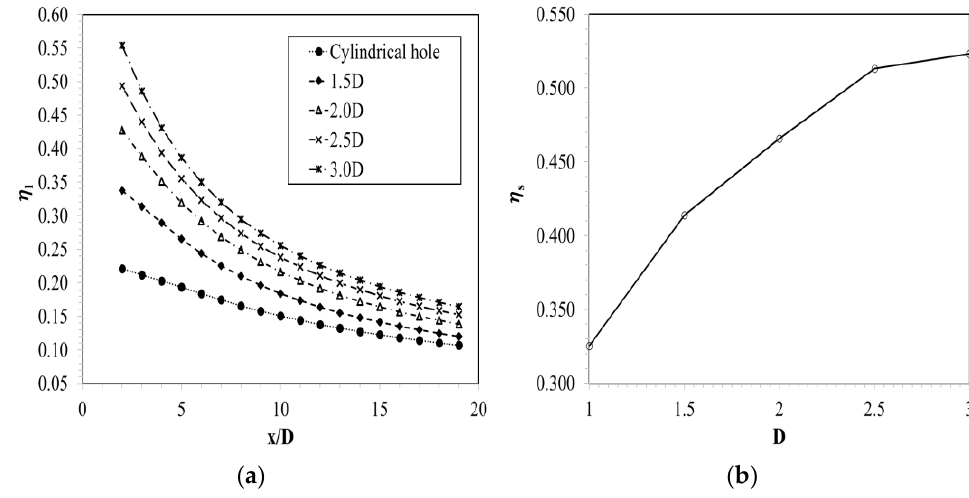
Figure 19. FE with expansion to the sides of the exit hole: ( a ) 𝜂 𝑙 , ( b ) 𝜂 𝑠 . Figure 20 indicates the local FE distribution contours on the x-y plane at z/D = 0. The